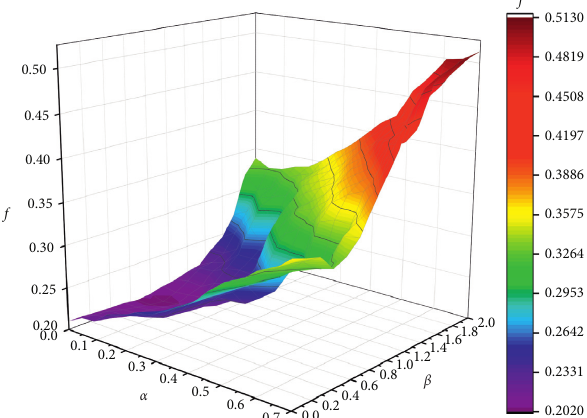
Figure 5: Disintegration evaluation metric f as a function of the proportion of missing links and ratio of the additional link information.